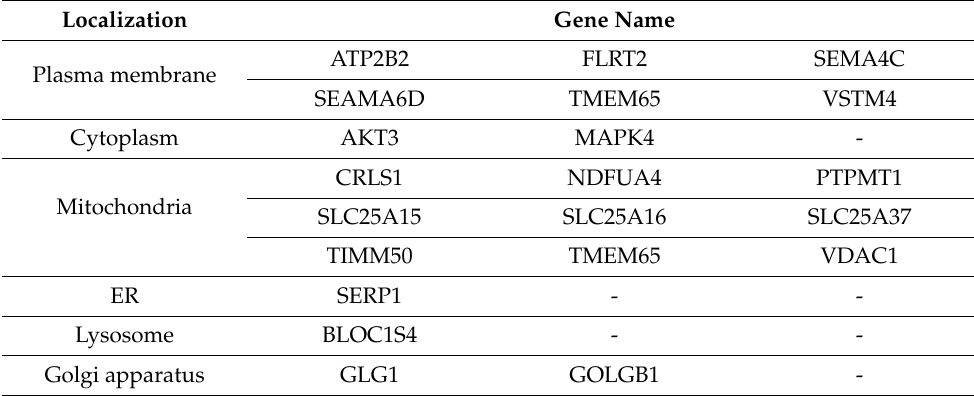
Table 3. miR-7-5p target genes.